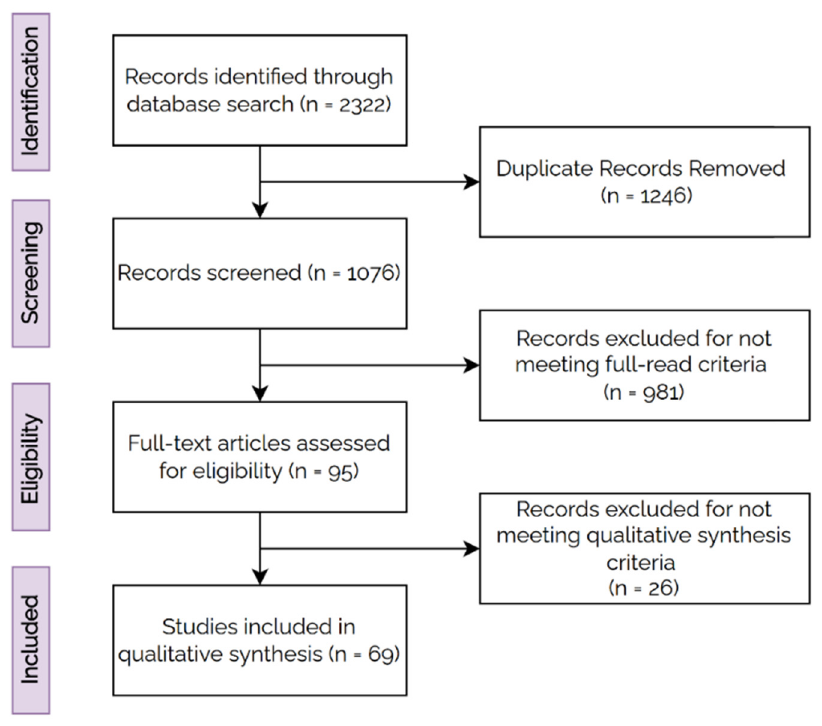
Figure 2. PRISMA Flowchart for inclusion criteria. Table 1. Summary of papers on AI for PDAC detection. The performance for the validation and test sets is reported with respective 95% Confidence Interval or standard deviation when it was